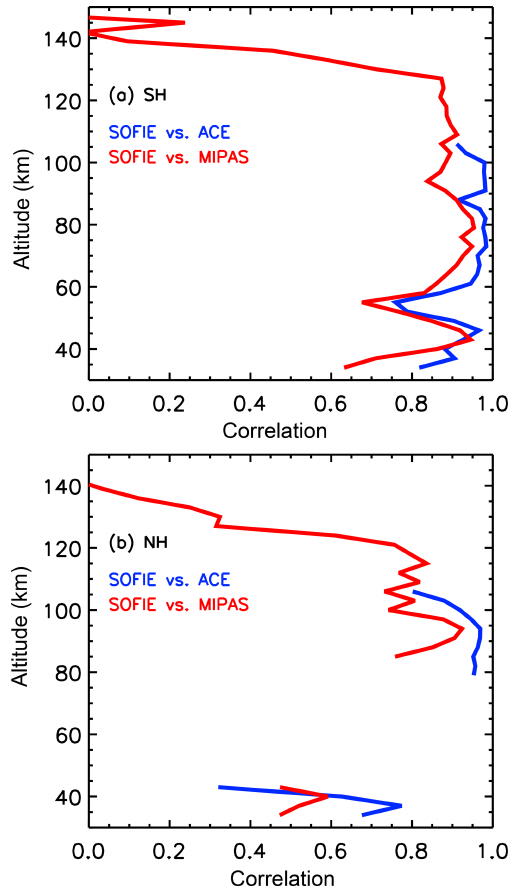
Figure 12. SOFIE–ACE and SOFIE–MIPAS correlation coeffi- cients for comparison of monthly mean NO time series (as in Figs. 10 and 11). Results are shown versus height in the (a) SH and (b) NH. Note that results are only shown when more than half of the monthly mean points were valid for both instruments, which was primarily a concern for the NH below ∼ 80km. Where results are shown, there were typically more than 40 points in the compari- son, for which the 95% significance level is a correlation coefficient of ∼ 0 . 3 or